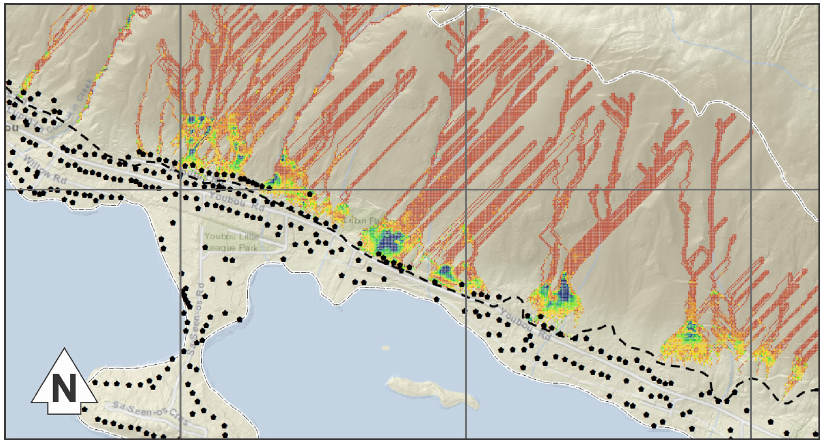
Figure 22. Damage map for the north shore of Cowichan Lake. The color classes match Fig. 21. The darker brown represents scour and transport zones and construction is assumed unlikely. Background image © ESRI World Topographic Map.